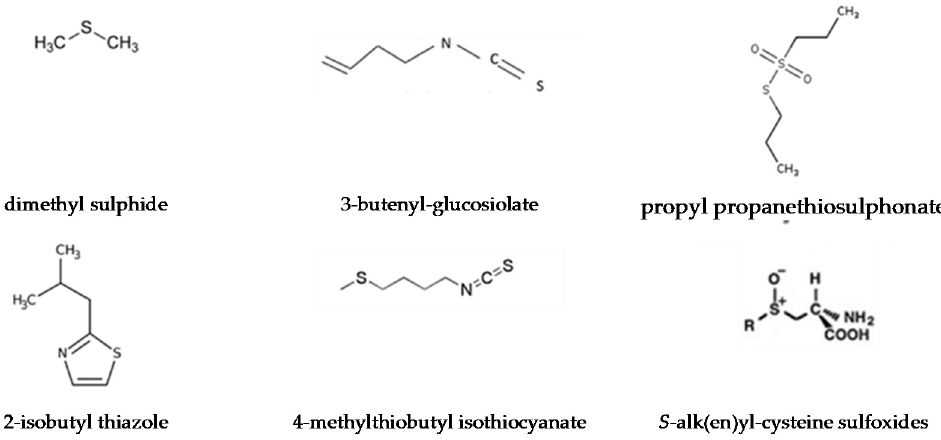
Figure 16. Chemical structure of sulphur-containing volatile compounds.